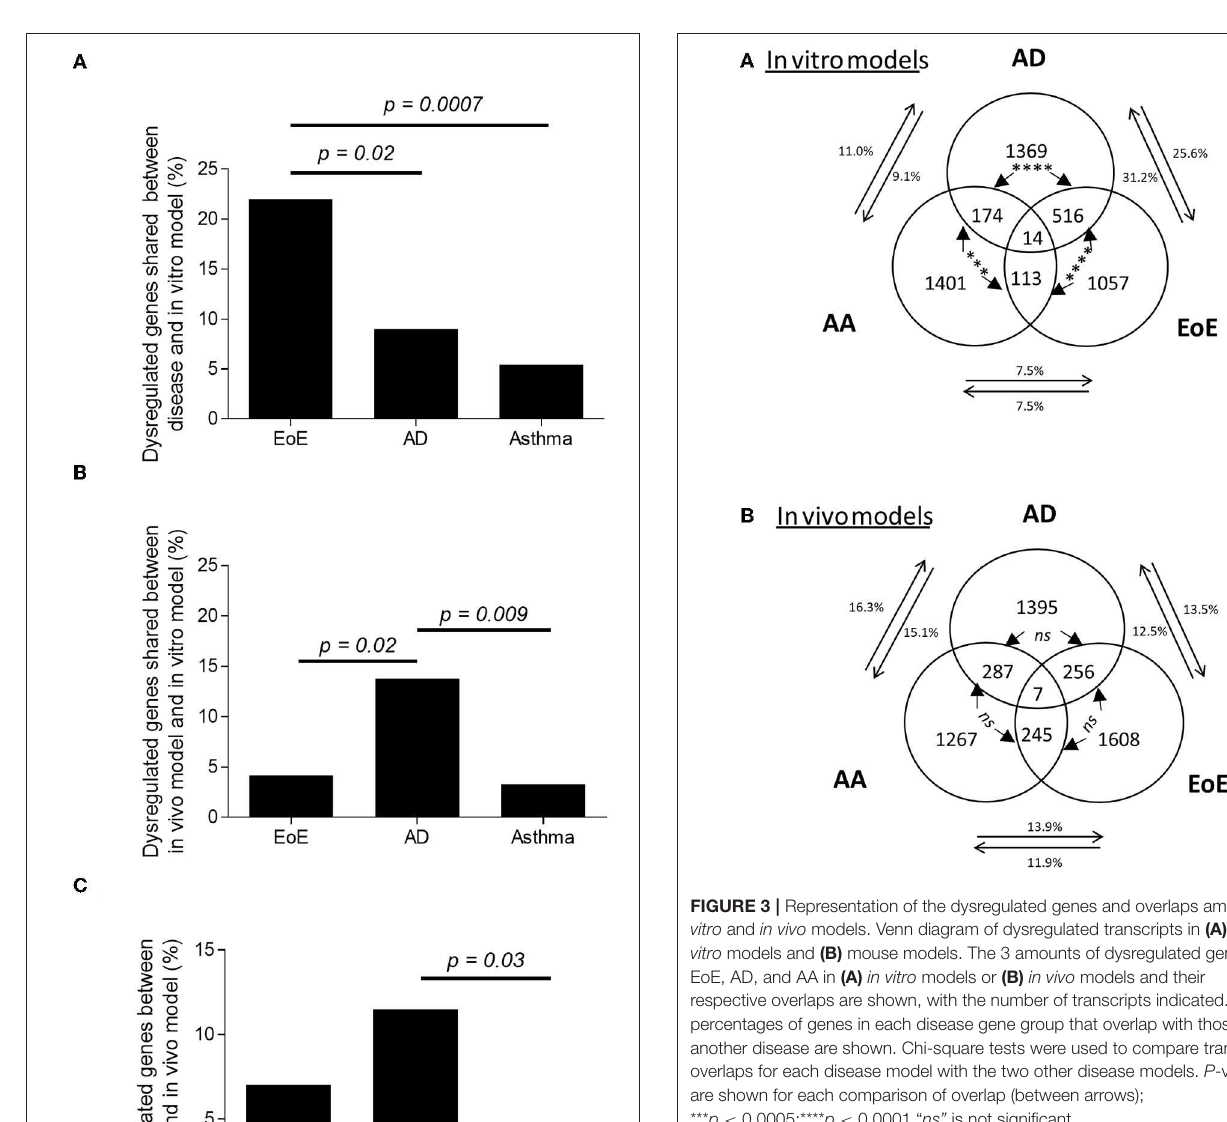
identified that among the models tested, the mouse model of AD had greater transcriptomic overlap with its human disease counterpart than did mouse models of EoE or AA. These